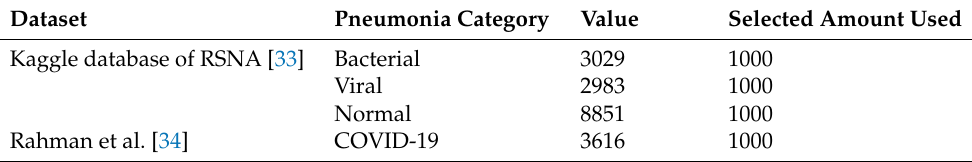
Table 2. Description of the Dataset.